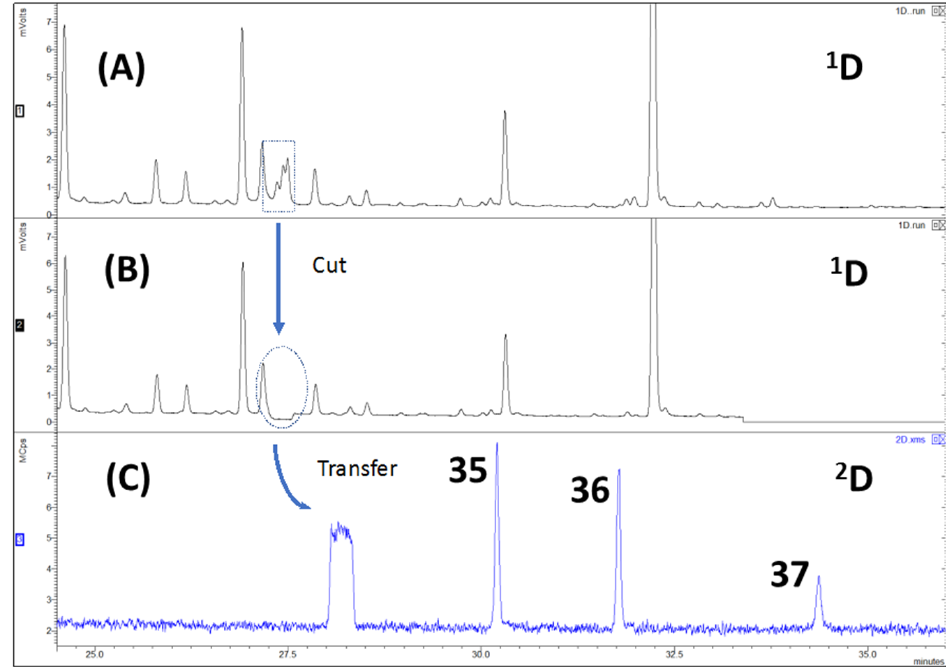
Figure 3. Example of chromatograms obtained by MD-GC of a HS-MonoTrap™ sample of E. globulus : ( A ) FID chromatogram; ( B ) FID heart-cut chromatogram; ( C ) TIC of the performed cut. Peaks are numbered according to Table 1. Analytical conditions are described in Section